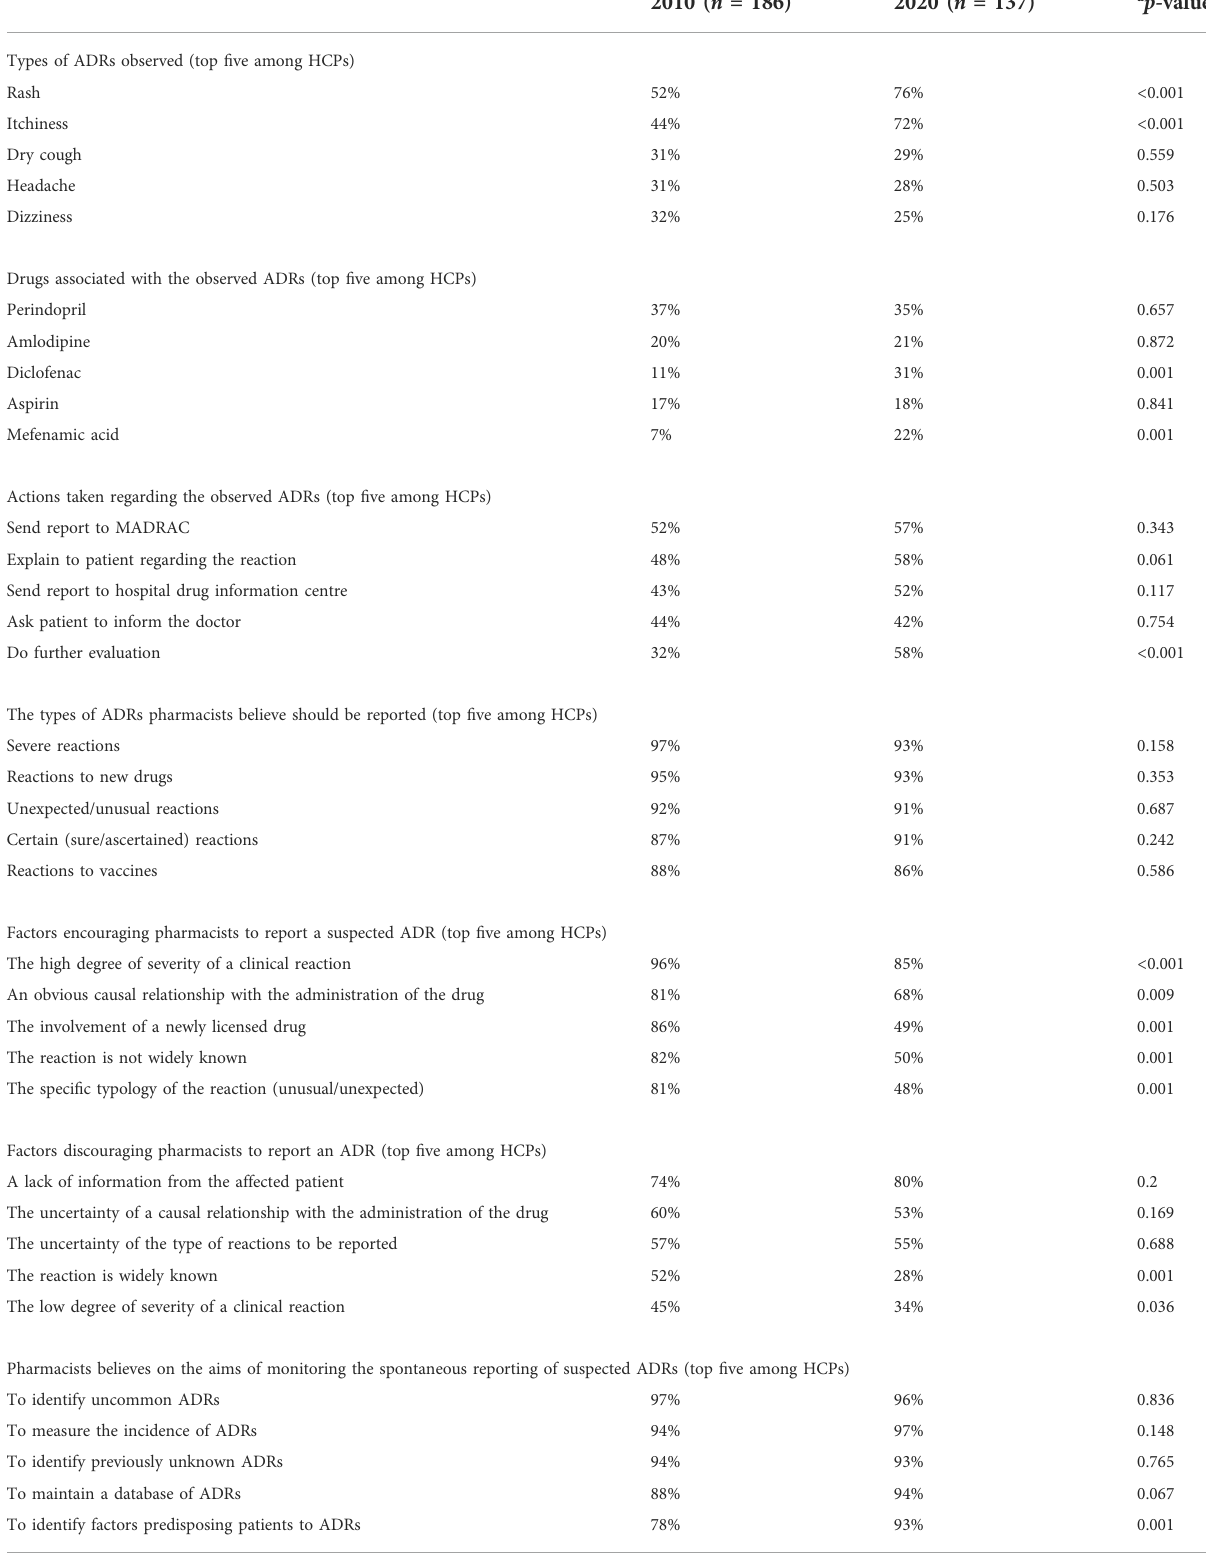
TABLE 4 Comparison between hospital/health clinic pharmacists (HCPs) in 2010 and